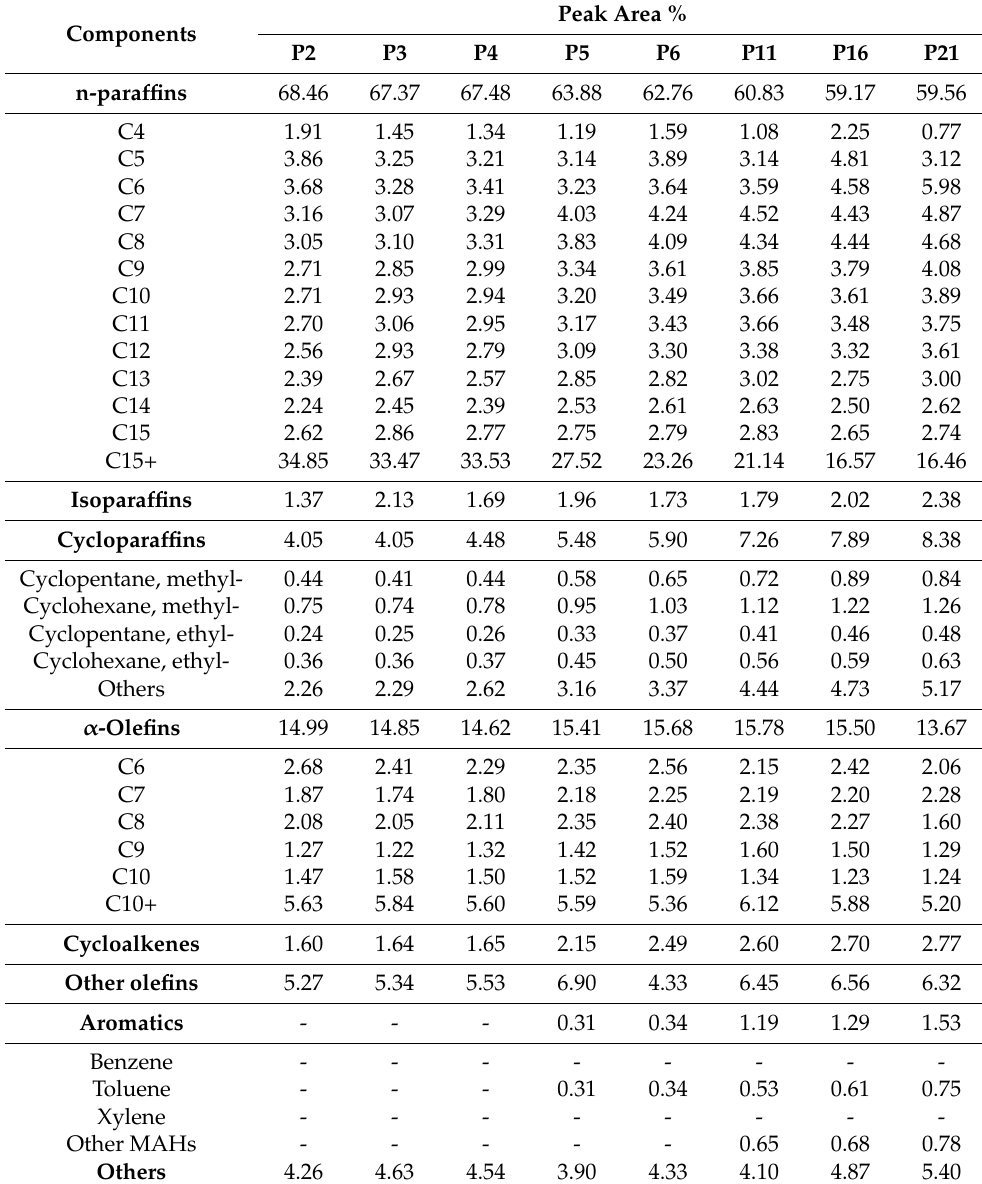
Table 3. Chemical composition of liquid products from different pressure experiments (listed in Table